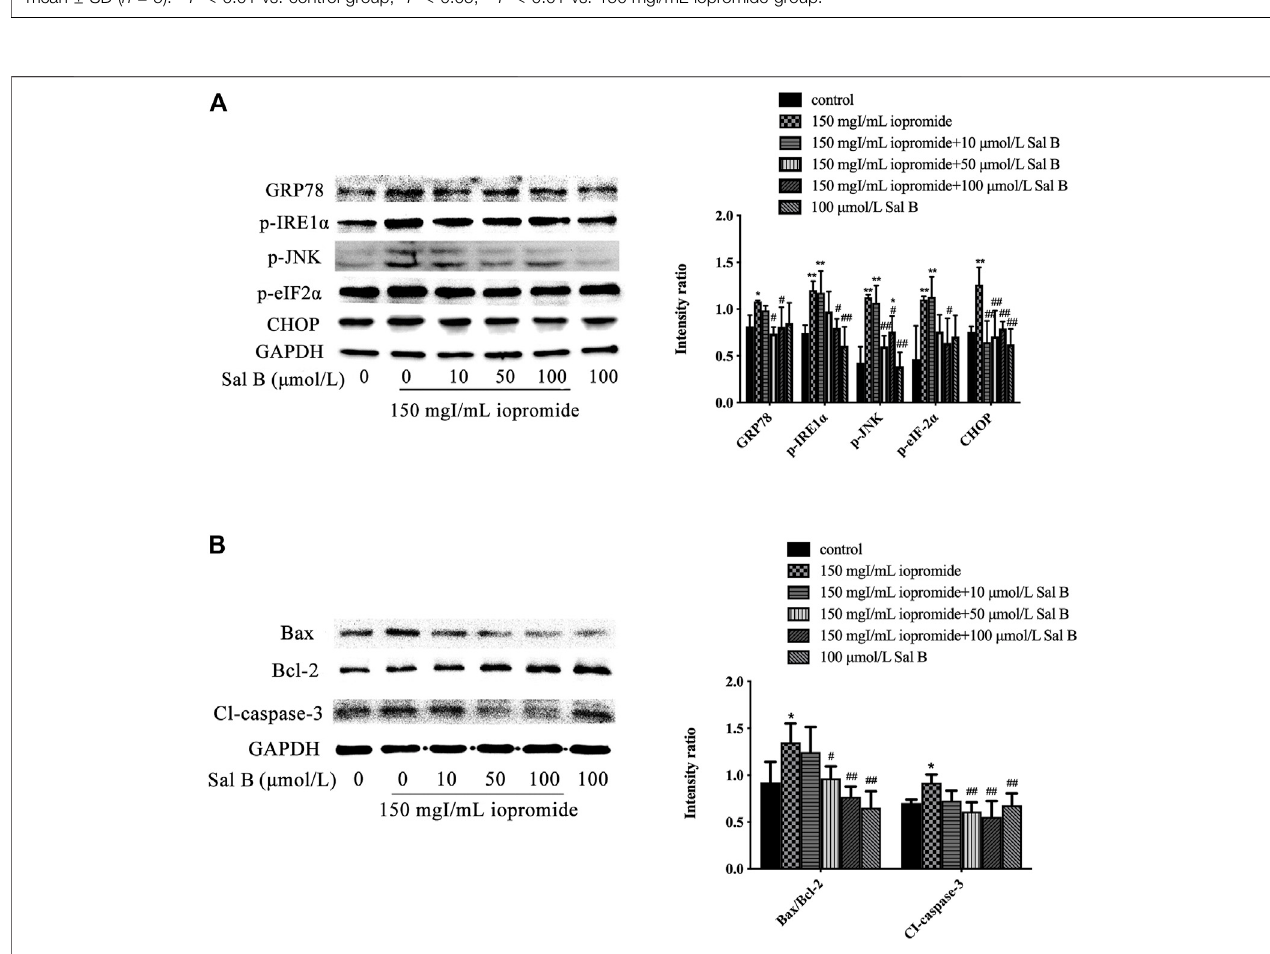
FIGURE2| DifferentconcentrationsofSalBwereexaminedforeffectsoniopromide-inducedGRP78,p-IRE-1 α ,p-JNK,p-eIF-2 α ,CHOP,Bax/Bcl-2,andcleaved caspase-3 protein levels in HK-2 cells. (A) Iopromide treatment caused a signi fi cant increase in GRP78, p-IRE-1 α , p-JNK, p-eIF-2 α , and CHOP. Sal B counteracted the iopromide-induced increase in these protein levels. (B) The protein levels of Bax/Bcl-2 and cleaved caspase-3 were signi fi cantly increased in iopromide-treated cells. These changes were alleviated by all tested concentrations of Sal B except for 10 μ mol/L. The data were determined by ANOVA and LSD post-hoc test and are presented as the mean ± SD ( n (cid:1) 3). * P < 0.05, ** P < 0.01 vs. control group; # P < 0.05, ## P < 0.01 vs. iopromide group.